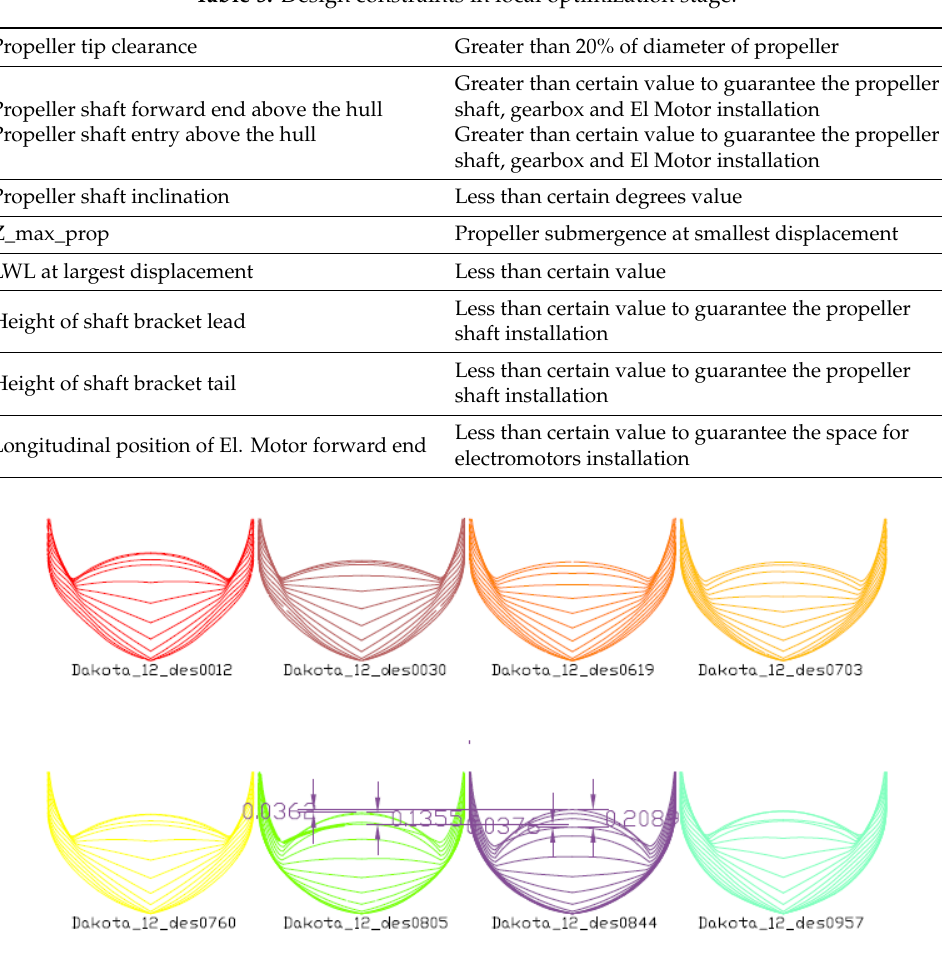
Figure 10. Transom stern design alternatives generated by local optimization.